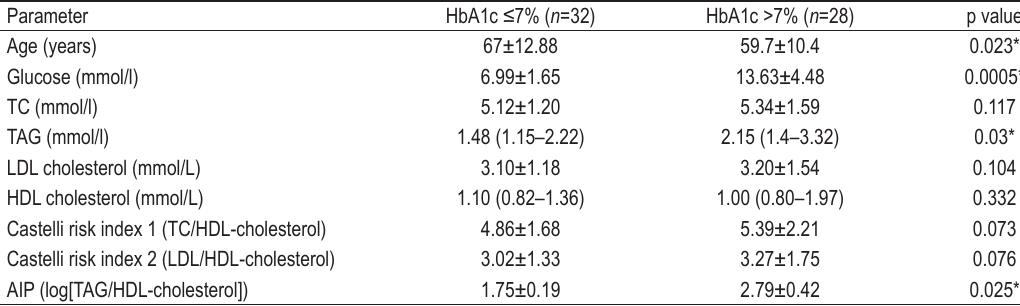
TABLE 1. Biochemical parameters categorized by patients’ glycemic control (HbA1c)